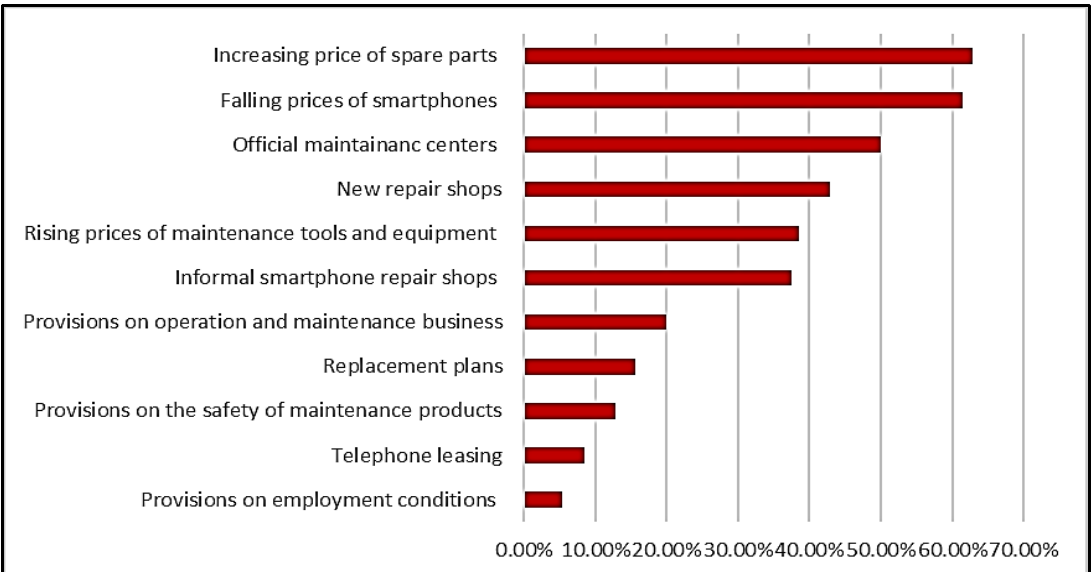
Figure 6. Business threats to mobile phone repair shops in China .